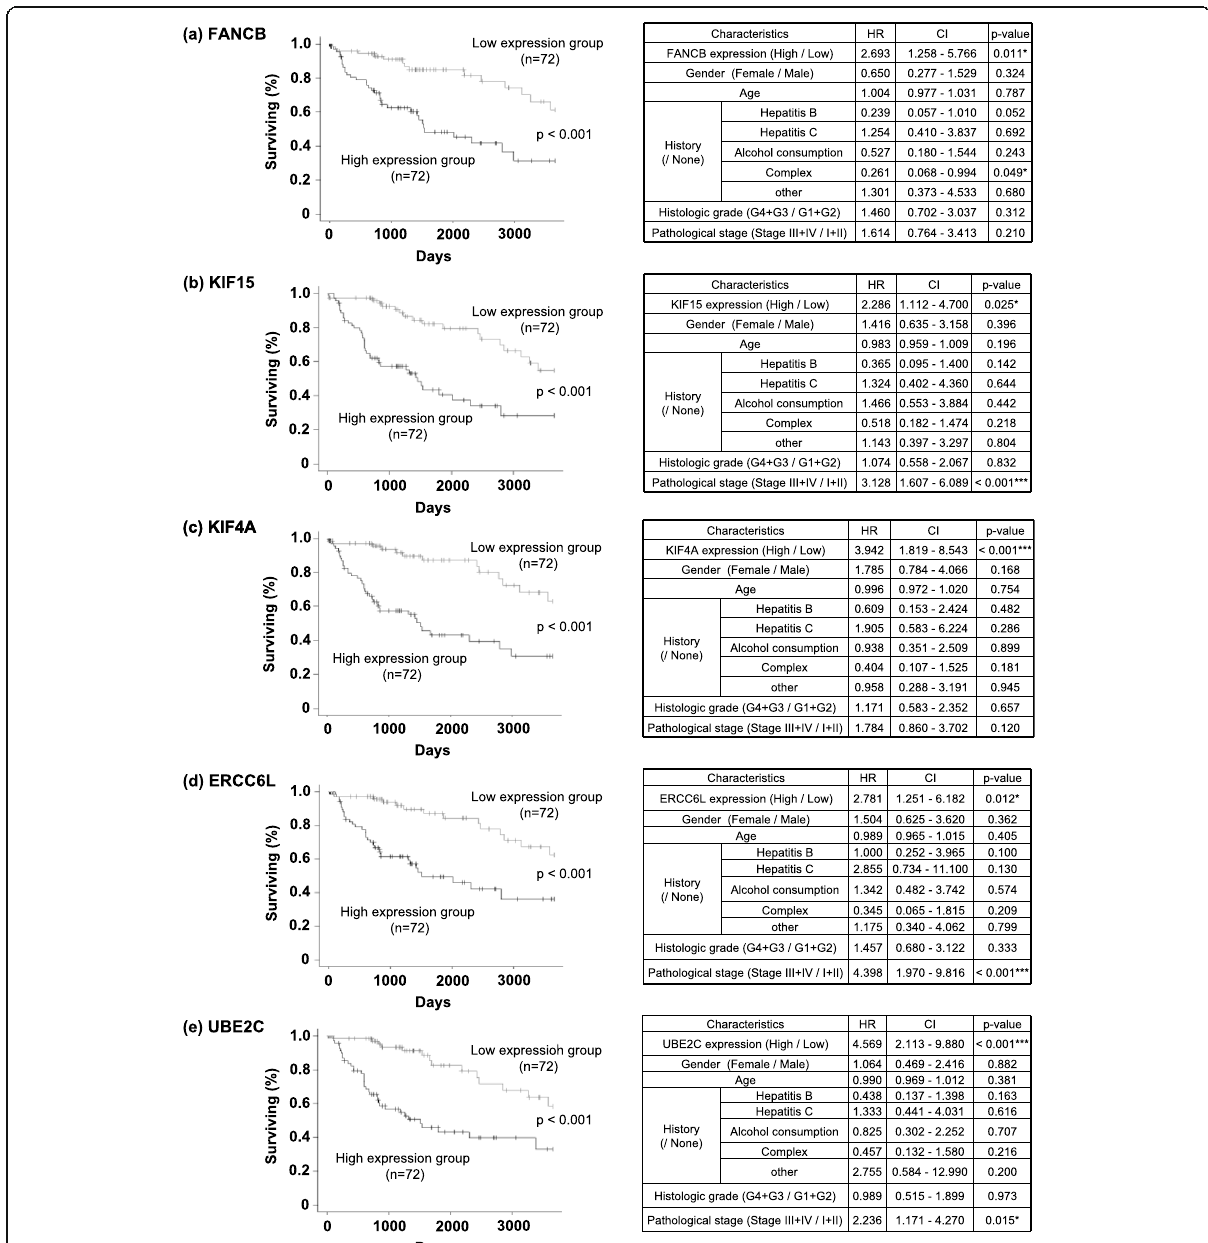
Fig. 5 Kaplan-Meier analysis and Cox regression analysis of overall survival of FANCB ( a ), KIF15 ( b ), KIF4A ( c ), ERCC6L ( d ), and UBE2C ( e ). Left figures and right tables were the results of Kaplan-Meier analysis and Cox regression analysis for 5-year survival data, respectively. Data from 72 HCC patients with higher or lower expression for each gene were selected in this study. A p value < 0.05 was considered statistically significant by log-rank test. In the Cox regression analysis, statistical significance is marked with the star symbol: * p < 0.05, ** p < 0.01, *** p < 0.001. HR hazard ratio, CI confidence interval. Complex: including more than two histories. Other: including non-alcoholic fatty liver disease, hemochromatosis, and “ other